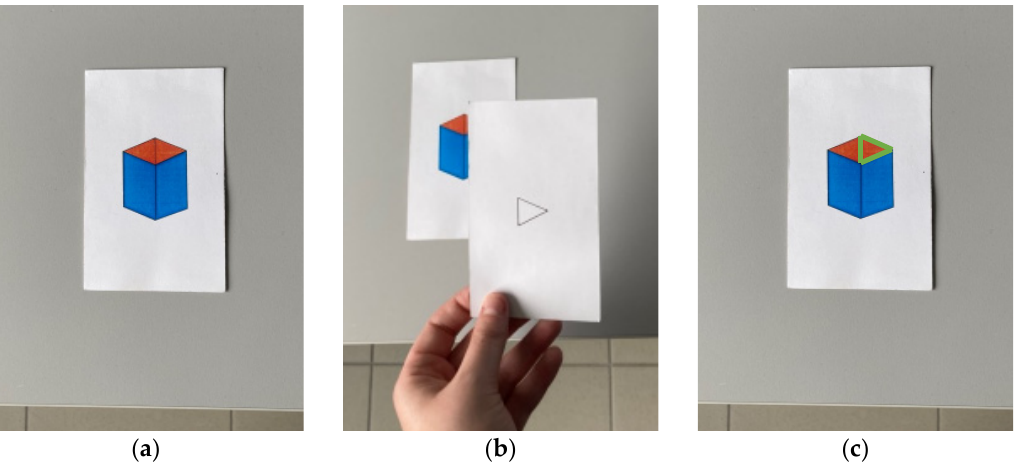
Figure 1. Picture and procedure of the Embedded Figures Test. The picture shows an example of the complex ( a ) and the simple ( b ) figures used and where the simple figure is hiding in the complex one ( c ).